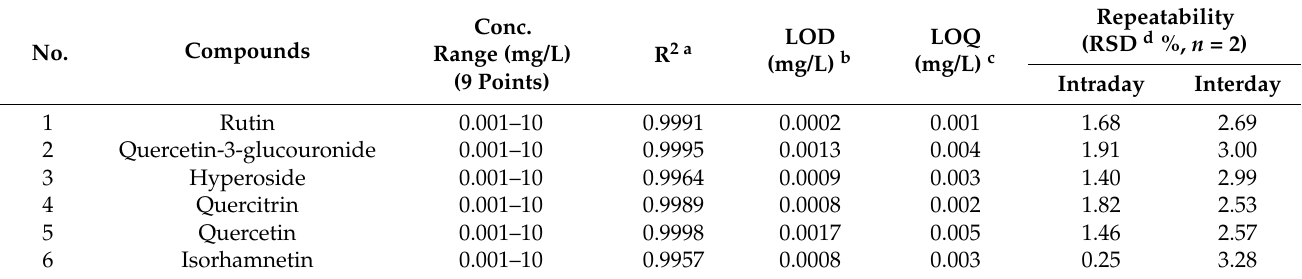
Table 3. Method validation data of the 6 analyzed flavonoids in green coffee beans by